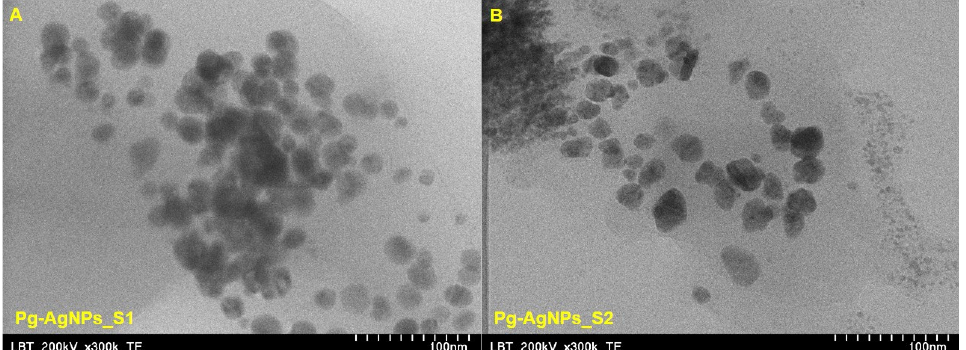
Figure 4. TEM images of Pg-AgNPs obtained by green-synthesis, starting from Pg extract, at 25 °C ( A —Pg-AgNPS_S1) and at 60 °C ( B —Pg-AgNPs_S2).